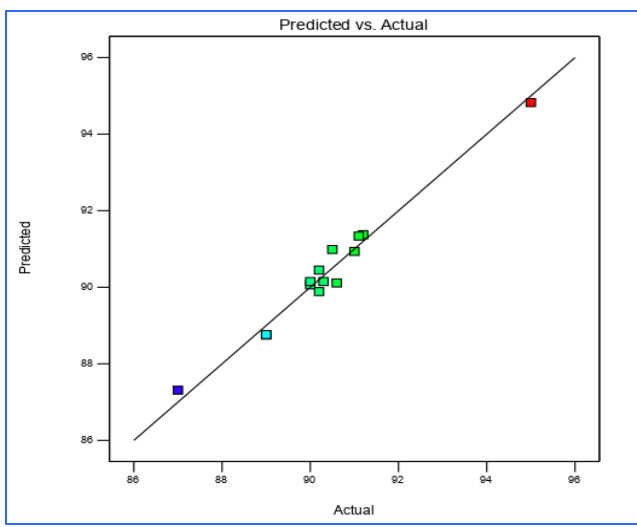
Figure 6. Linear correlation plot between actual and predicted values for KA yield.